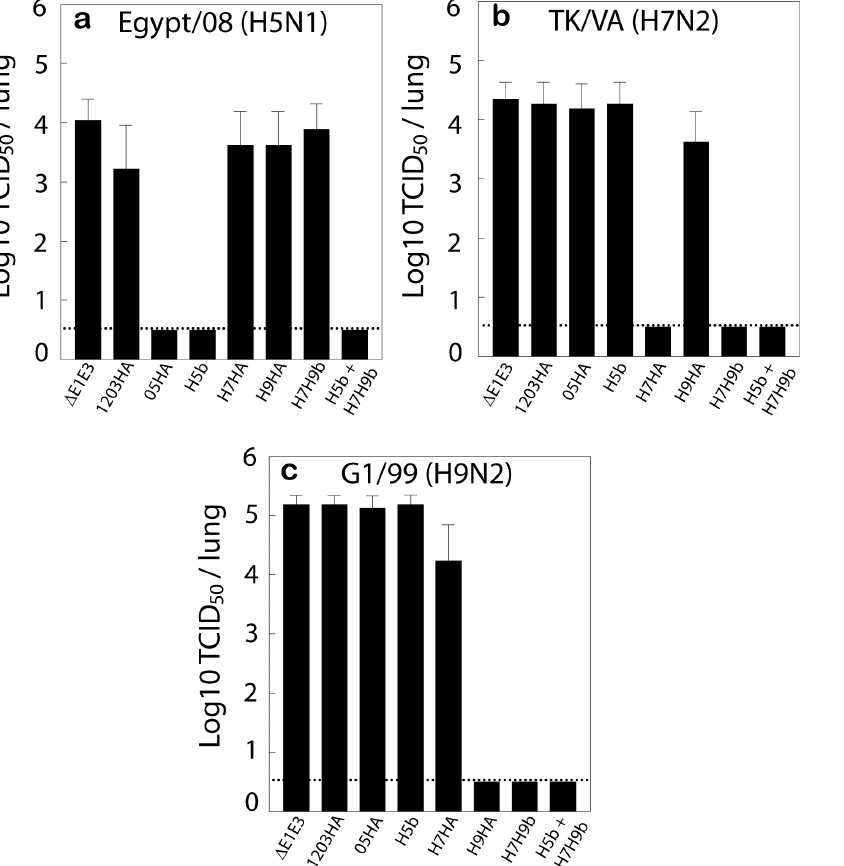
Figure 3. Protective efficacy of AdV vector-based vaccines against challenge with influenza viruses from H5, H7, and H9 subtypes. Mouse groups were immunized with 1203HA, 05HA, H5b, H7HA, H9HA, H7H9b, H5b + H7H9b or D E1E3 twice at four-week intervals. Four weeks post- booster inoculation, the mice (5 animals/group) were challenged with one of the following viruses: Egypt/08 (a), TK/VA (b), or G1/99 (c). Three days after challenge, the animals were euthanized, and the lung virus titers were determined as described under Materials and Methods. The data represent the mean virus titers 6 standard deviation (SD). The detection limit of the lung viral titer was 0.5 Log 10 TCID 50 /ml. 1203HA, HAd-1203HA; 05HA, HAd-05HA; H5b, HAd-1203HA-05HA; H7HA, HAd-H7HA; H9HA, HAd-H9HA; H7H9b, HAd-H7HA-H9HA; H5b + H7H9b; HAd-1203HA-05HA + HAd- H7HA-H9HA; D E1E3, HAd- D E1E3; Egypt/08, A/Egypt/3300-NAMRU3/2008 (H5N1)-PR8-IDCDC-RG13; TK/VA, A/turkey/Virginia/2002 (H7N2)-PR8-IBCDC- 5; G1/99, A/Hong Kong/1073/1999